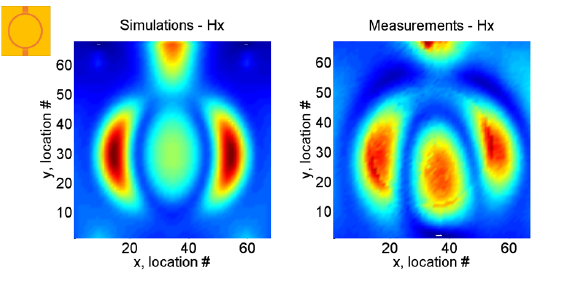
Figure 10: | H x | magnitude of the magnetic field for simula- tions (CST (cid:114) , left) and measurements (right) in the vicinity of the empty ring resonator at f = 2 . 66 GHz.